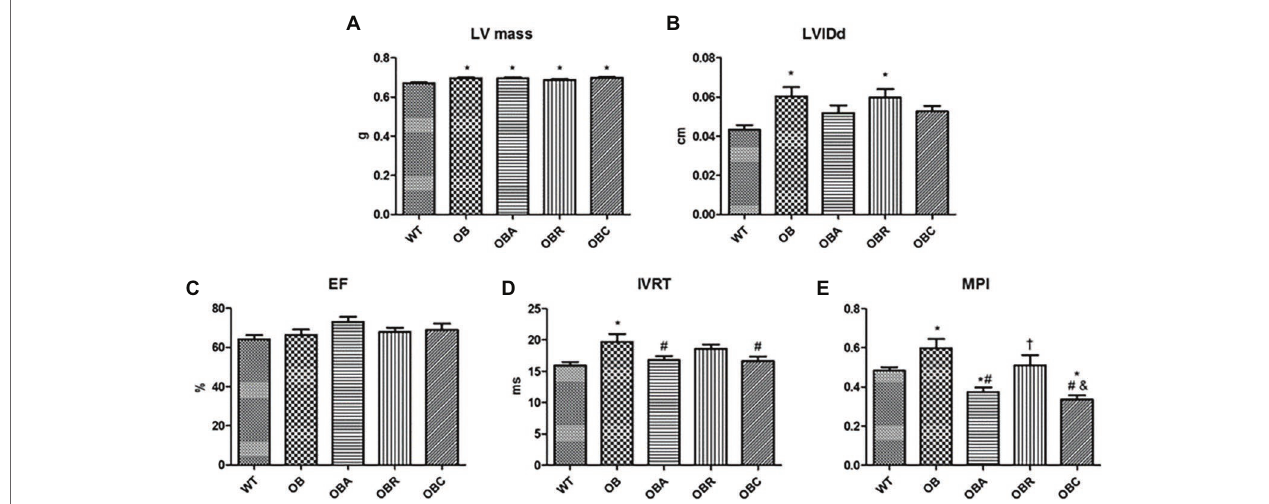
FIGURE 3 | (A) Left ventricle mass; (B) left ventricle intern diameter in diastole; (C) ejection fraction; (D) isovolumic relaxation time; (E) myocardial performance index. Values are mean ± SE. * p < 0.05 vs. WT; # p < 0.05 vs. OB; † p < 0.05 vs. OBA; & p < 0.05 vs.